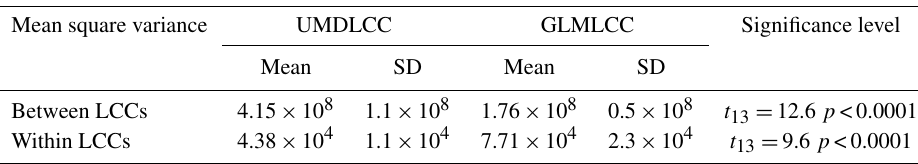
Table 1. Mean, standard deviation, and t test of mean square variance of reference NPP (gCm − 2 yr − 1 ) for UMDLCC and GLMLCC, partitioned into between-LCC and within-LCC.